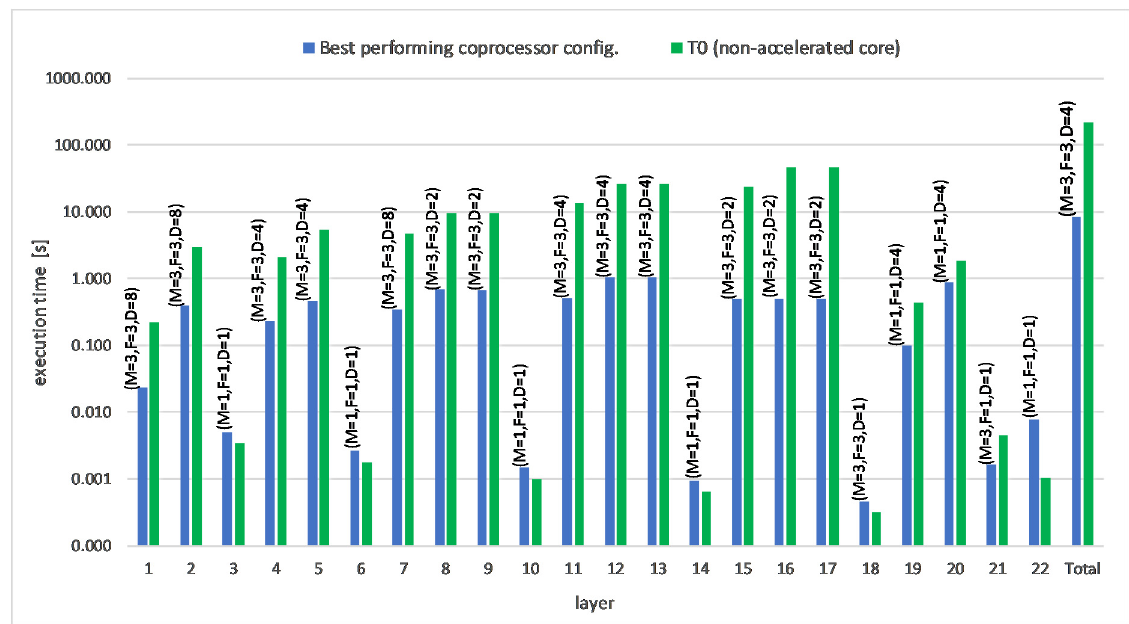
Figure 15. Absolute execution time [s] of the best performing accelerated configuration and of the non-accelerated T0 core, per